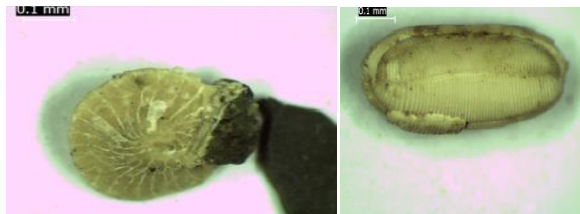
Figure 9: Photomicrographs of Laki Formation shale in Khadeji well showing Alveolina oblonga and coralline algae